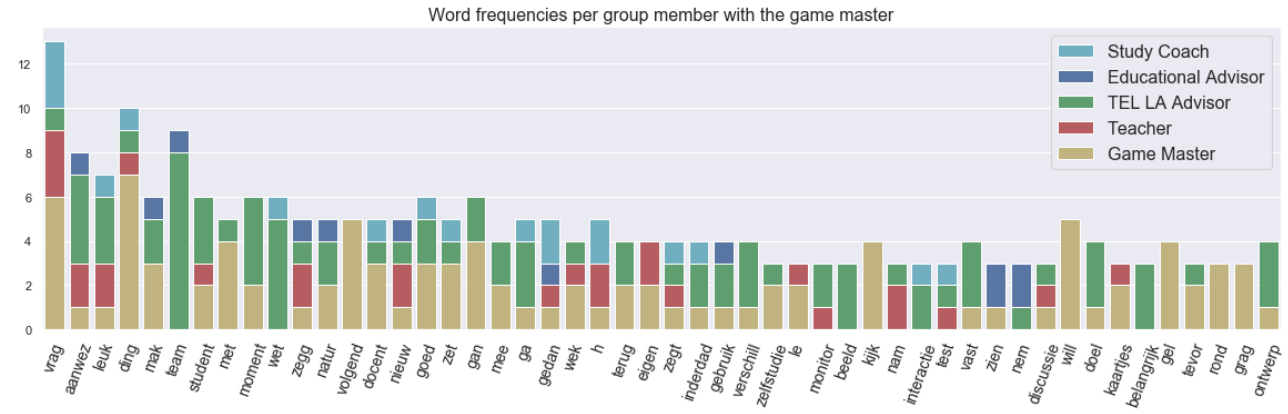
Figure 8. Top 50 word utterance frequency in the yellow phase with